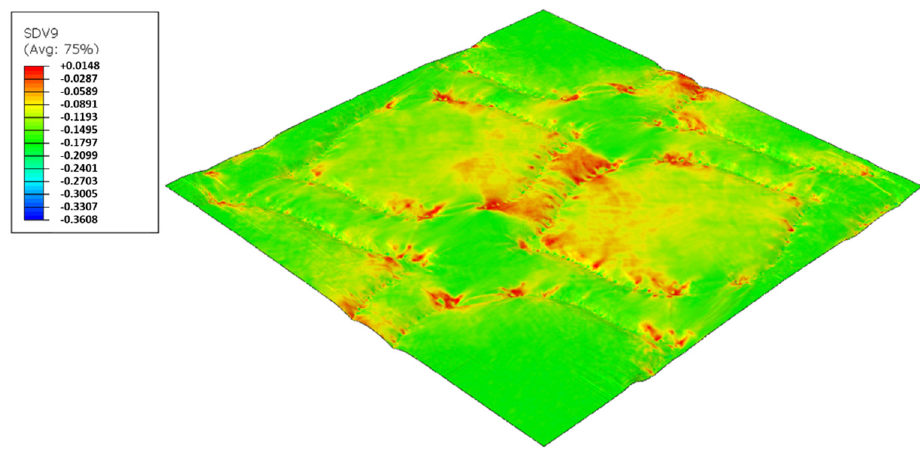
Figure 19. Deco die 48 Sh-A (NR BG), Plastic field.